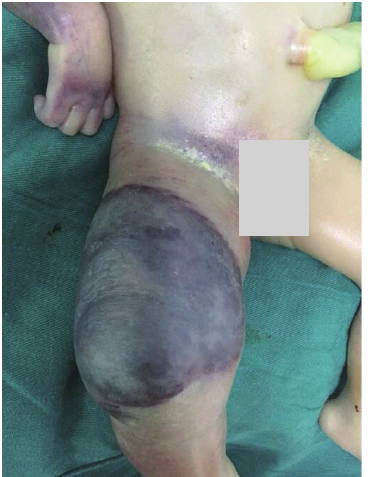
Figure 3 A photograph showed the dark-purple lesion on the right thigh of the fetus after induced